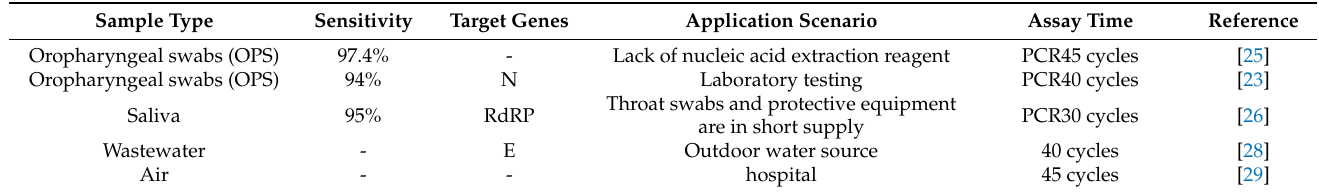
Table 1. The data and applications of off-chip PCR detection technology were